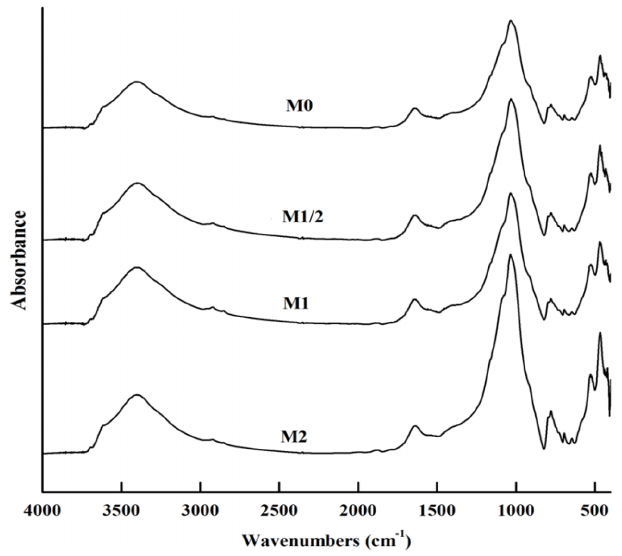
Figure 1. FTIR spectra of bulk SOM under different long-term mowing